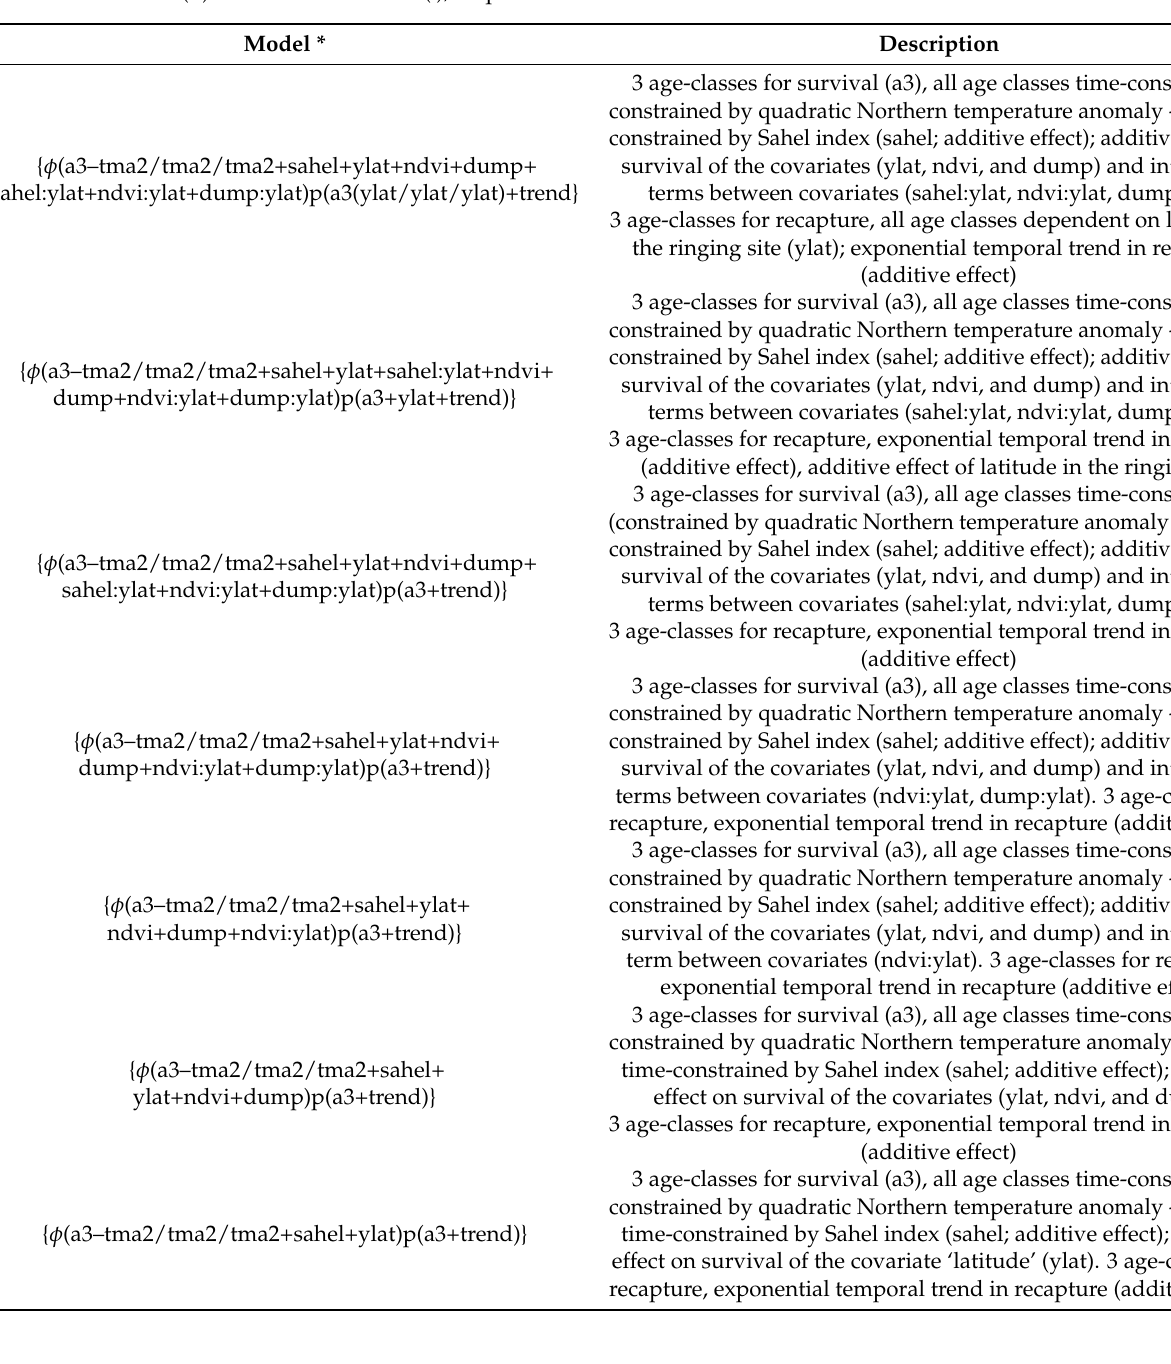
Table 1. Description of the models that were assessed. Naming convention from [43]; (t)p(t) as a model with full time- dependence (t) for both survival ( φ ) and recapture (p). * a3: three age classes (juvenile (first)/ immature (second)/ adult (third)); tma: Northern Hemisphere Temperature Anomaly; sahel: Sahel index anomaly; ylat: latitude of the ringing site; ndvi: trend (1982–2006) in NDVI in the ringing site; dump: mean distance to dump from the ringing site (1990–2016). Additive effect (+) and interaction term (:); 2: quadratic